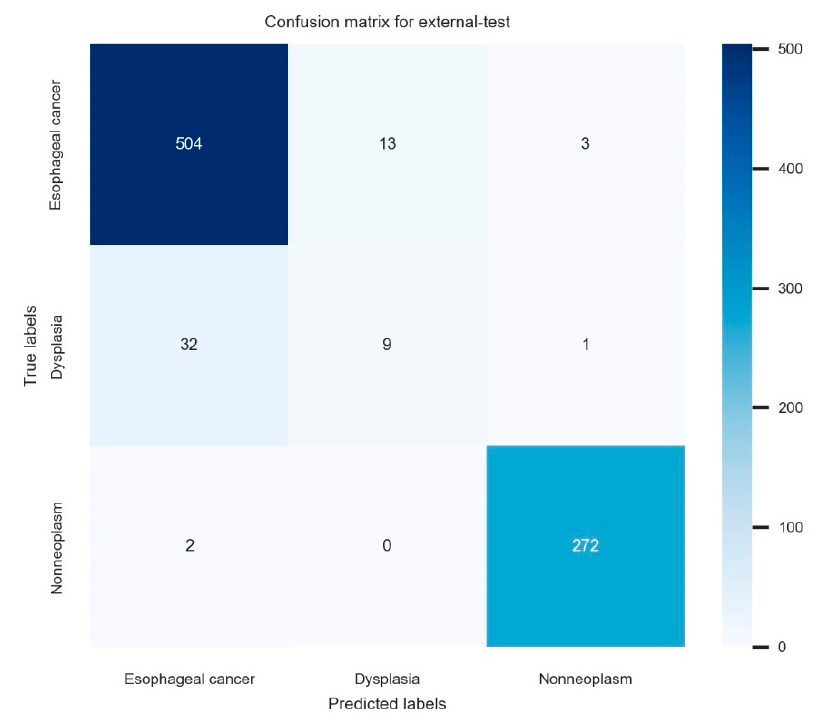
Figure 3. The confusion matrix for the established model in the external